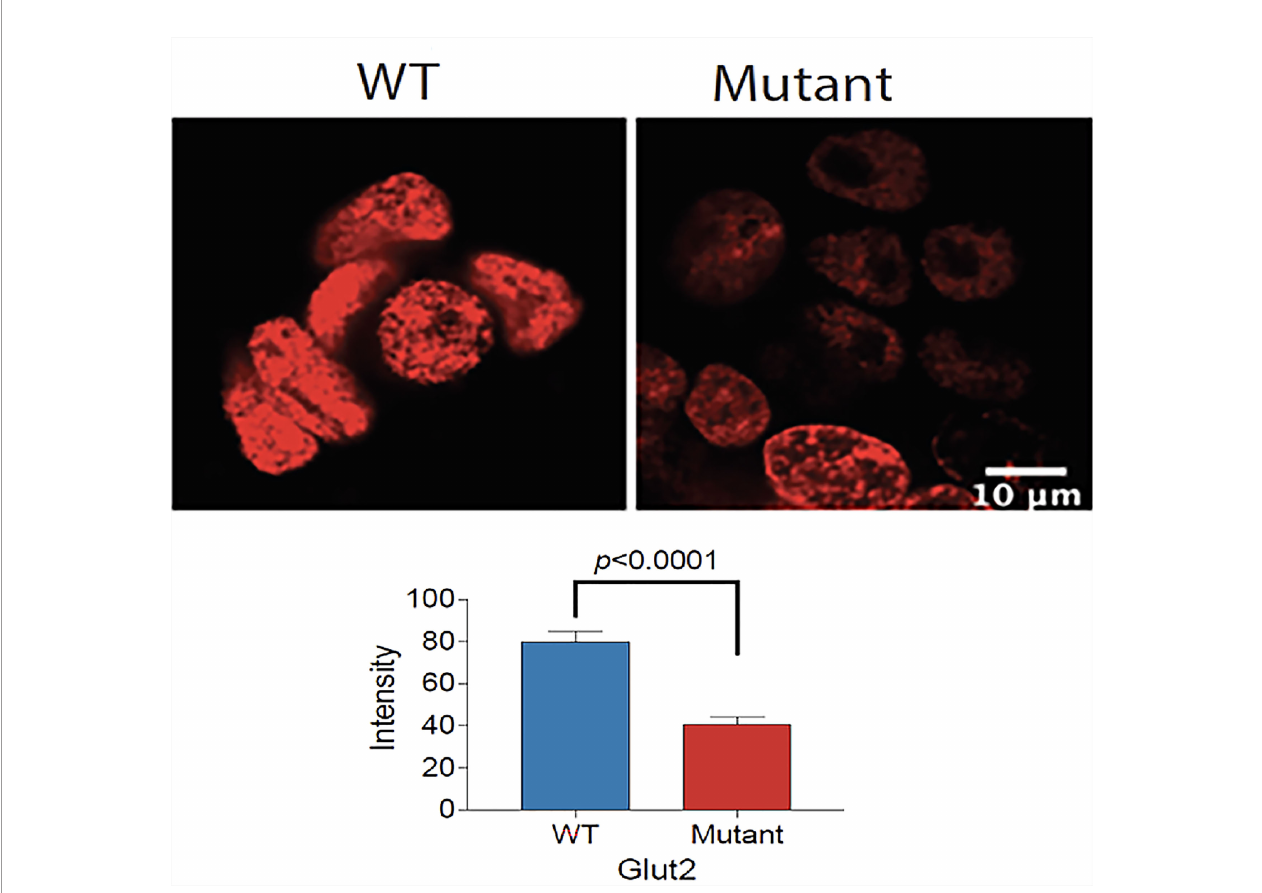
FIGURE 4 | Reduced proliferation of GLUT2 mutant cells. Top panel: Confocal fl uorescence images of WT and mutant GLUT2 expressing HEK293T cell nuclei showing reduced Edu incorporation. Lower panel: Graph showing Edu intensity in the nuclei of WT and mutant GLUT2 expressing HEK293T showing signi fi cantly lower Edu intensities (p<0.0001). Analysis based on single cell nuclei